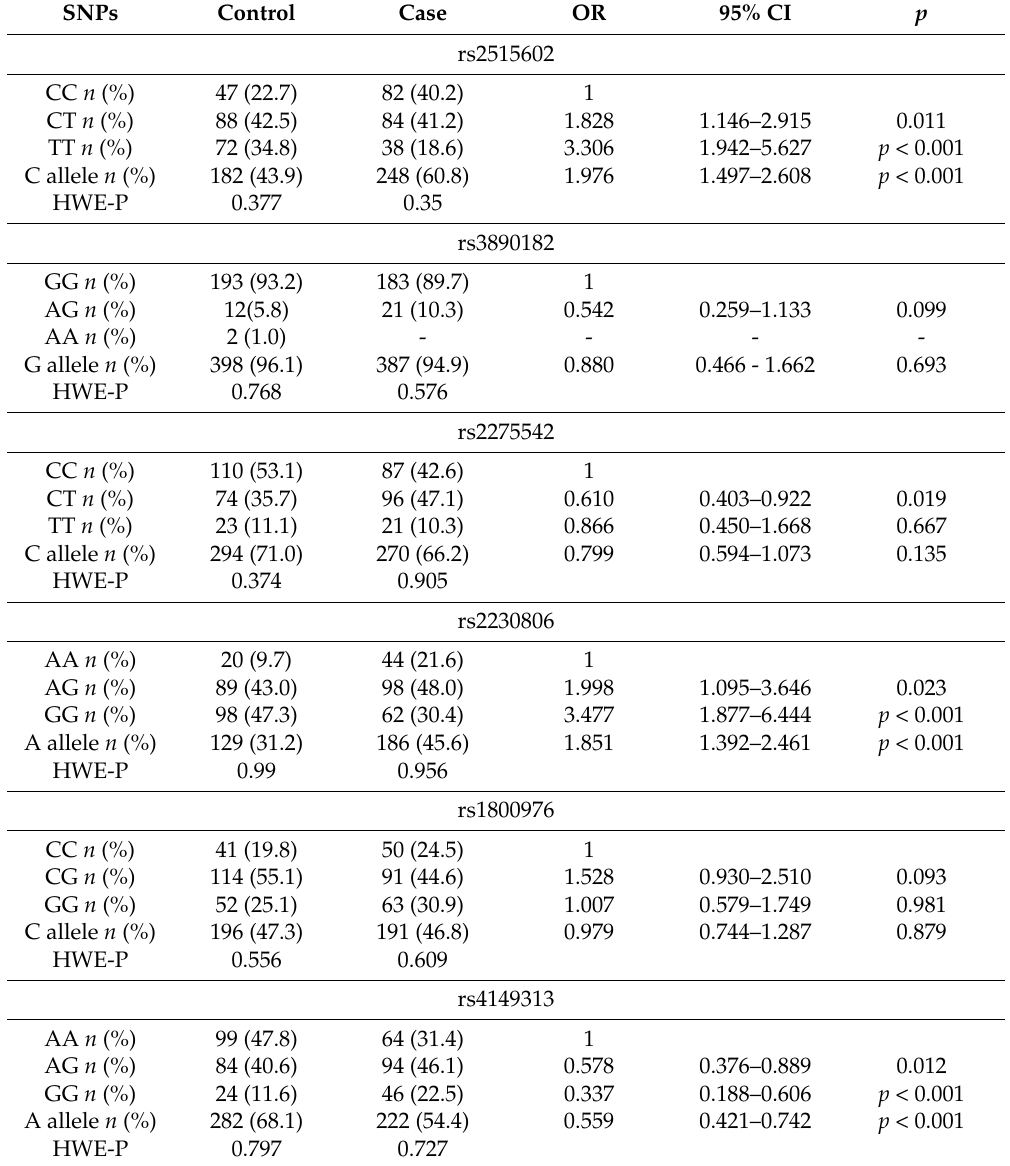
Table 3. The genotypic and allelic frequencies between the subjects with normal HDL-C and low